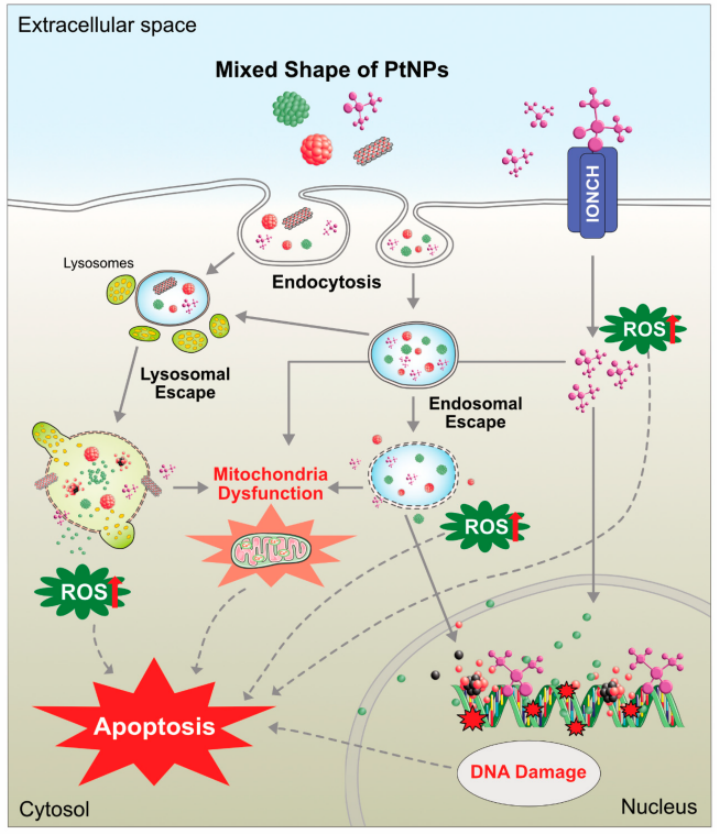
Figure 9. The possible mechanism of platinum nanoparticle-induced cytotoxicity in cancer cell lines. Copied from MDPI [186].